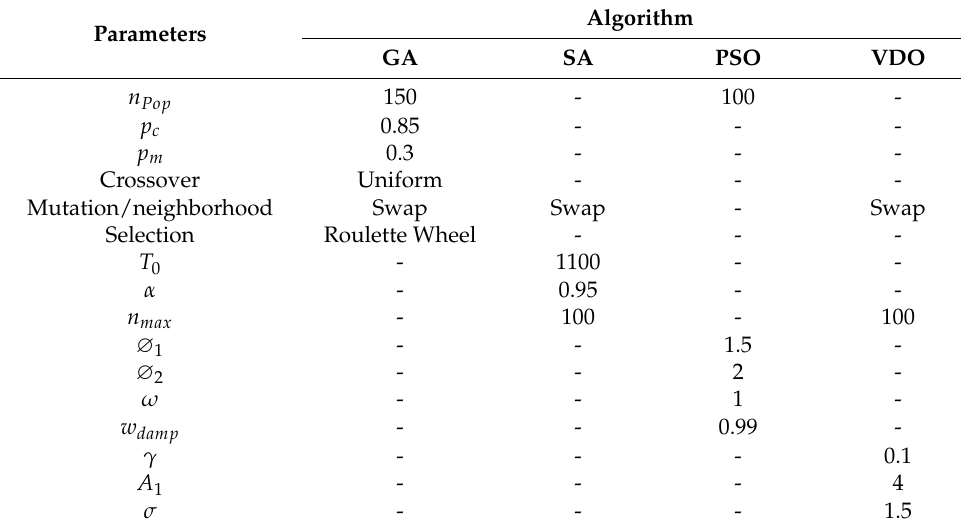
Table 5. The best levels of the parameters of the proposed